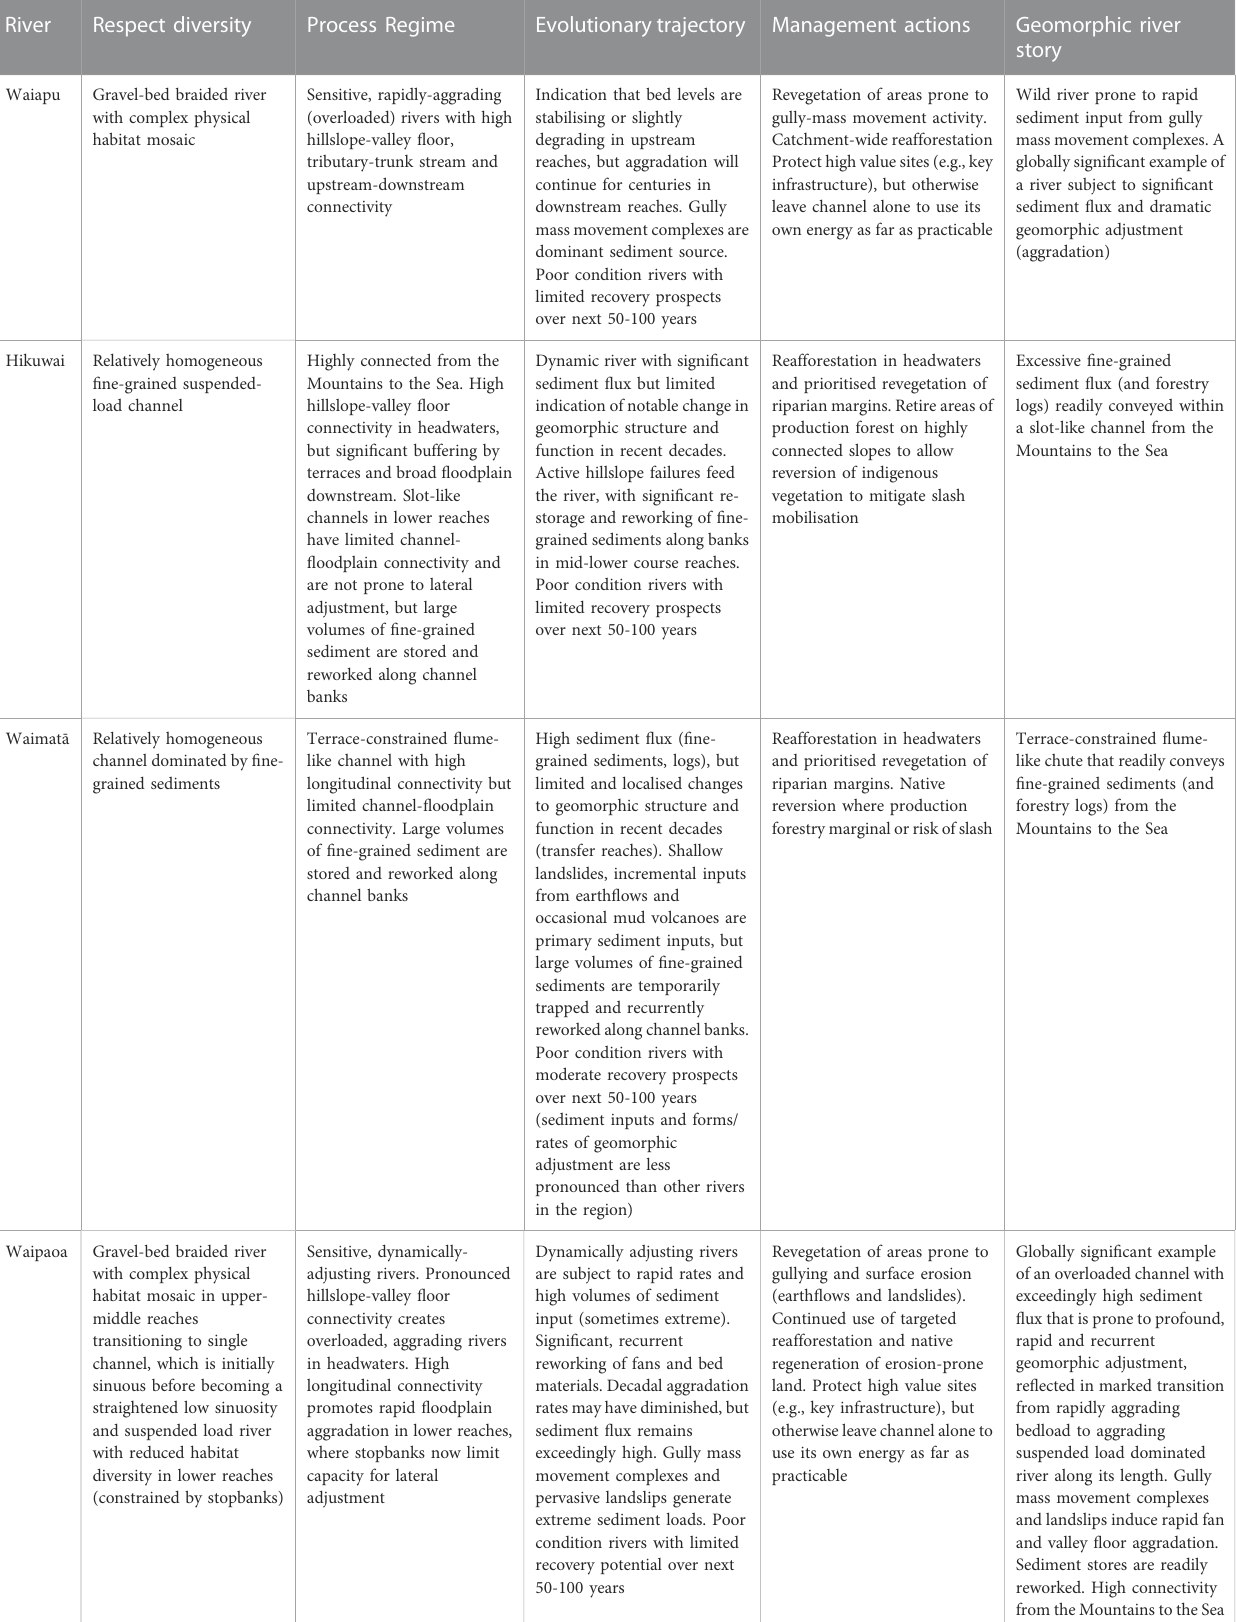
TABLE 2 Application of geomorphic principles (Table 1) to generate river stories that support rehabilitation of Tair ā whiti catchments.